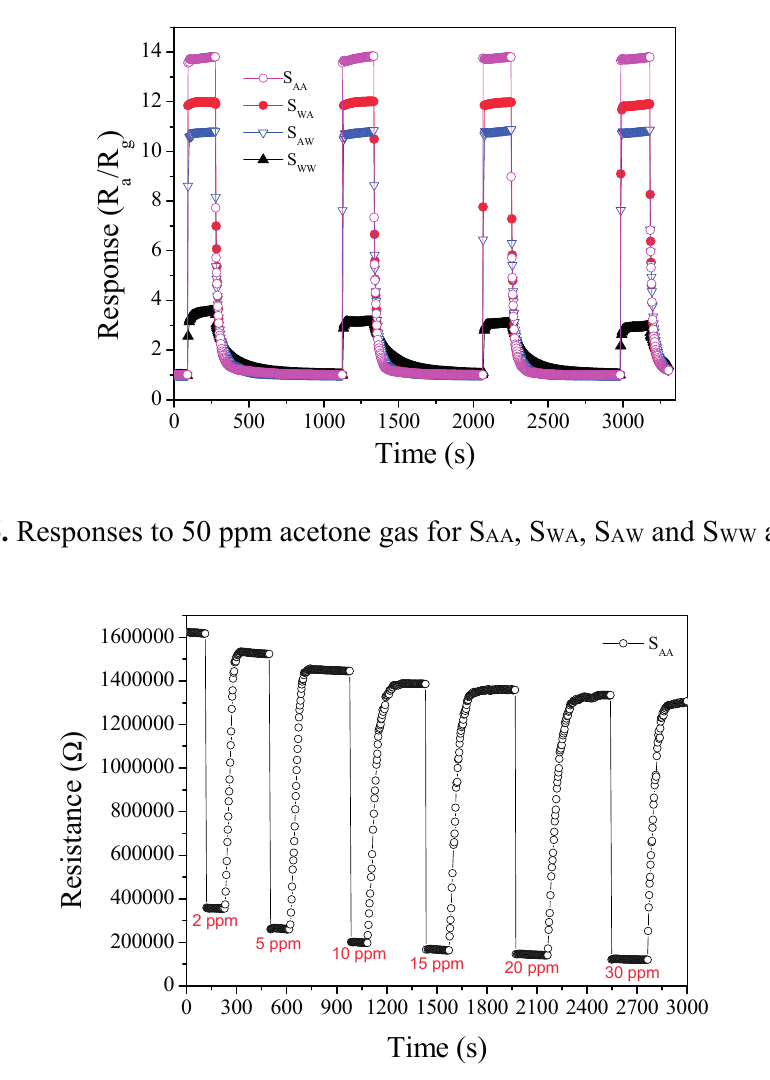
Figure 7. Response transients to different concentrations of acetone for S AA at 250 °C.